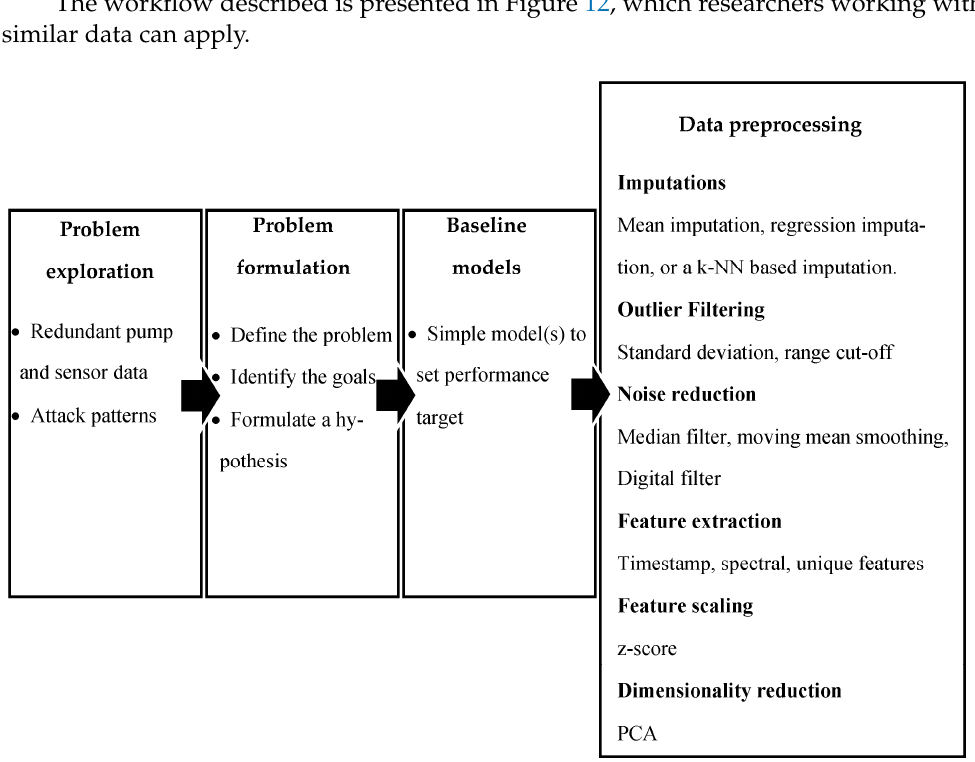
Figure 12. Work fl ow for treating process data from industrial control systems. Figure 12. Workflow for treating process data from industrial control